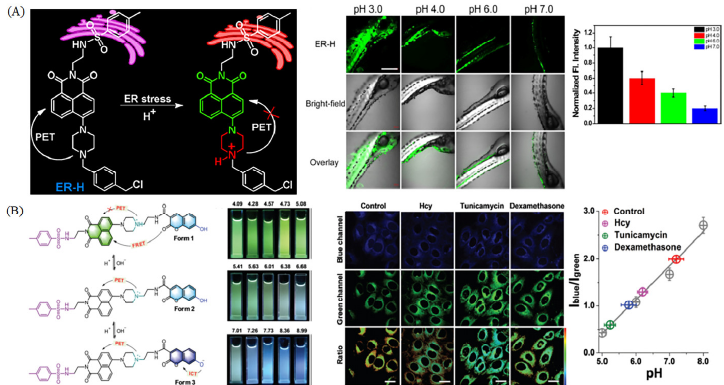
Figure 17. ( A ) Response mechanism of ER-H to pH, and the relative two-photon fluorescence imaging of zebrafish in diverse pH. The column diagram is the relative intensity changes. Reproduced from 95 with permission of the Elsevier, copyright 2018. ( B ) The pH-response mechanism and photographs of CNER-pH under irradiation at 365 nm; fluorescence images of HeLa cells stained with CNER-pH stimulated with Hcy, tunicamycin or dexamethanose, and the corresponding quantitative data. Reproduced from [94] with permission of the Royal Society of Chemistry, copyright 2019.